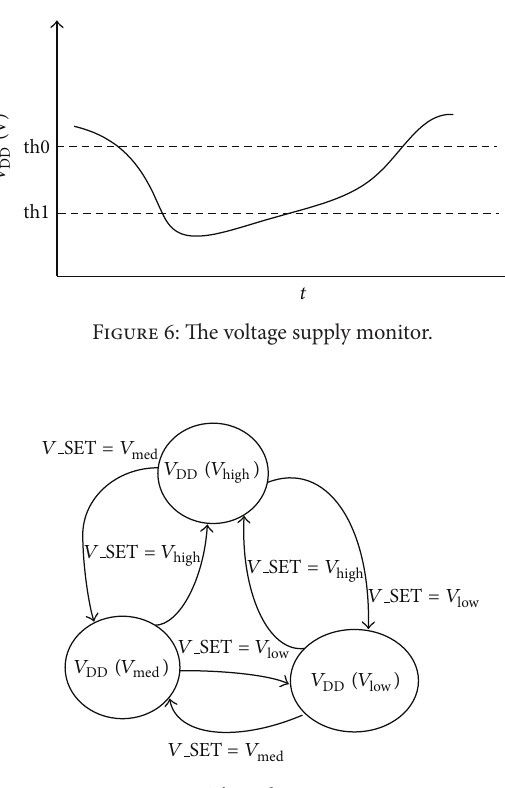
Figure 7: The voltage